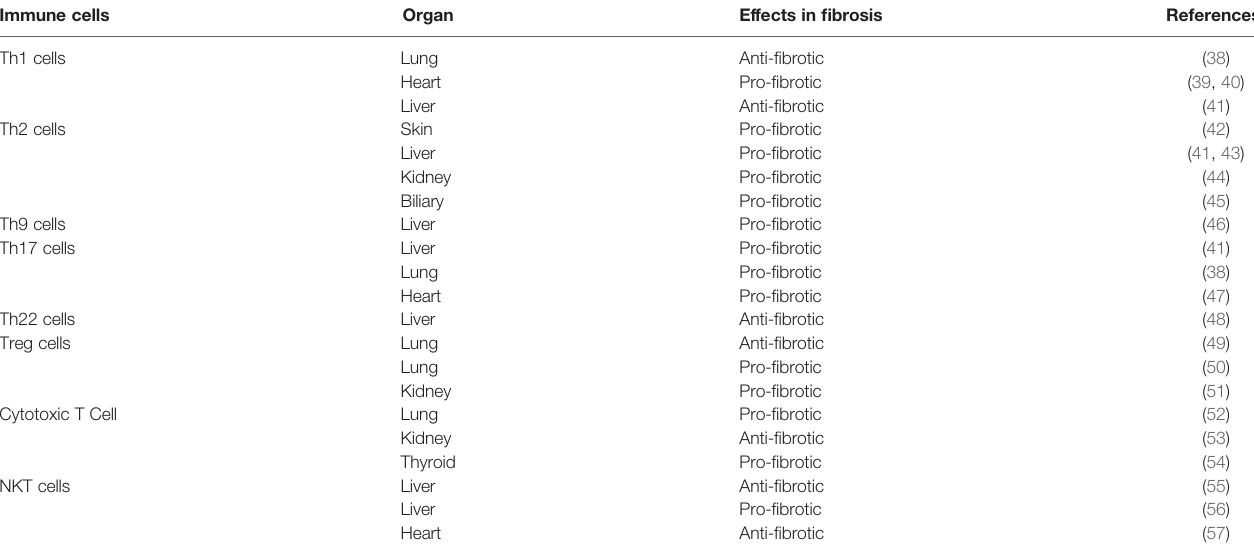
TABLE 1 | Function of T cells subsets in different fi brosis. Immune cells